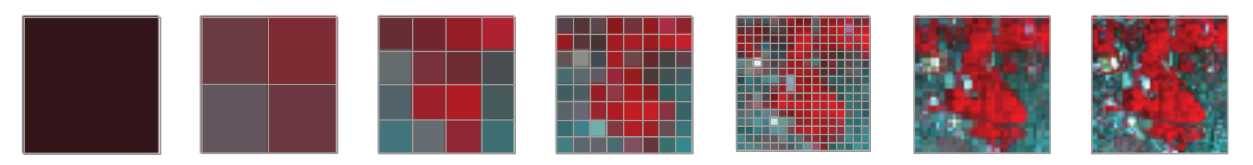
Figure 2. False-color images of the spectral data at several resolution levels used to simulate the scaling effect in the calculation of an averaged